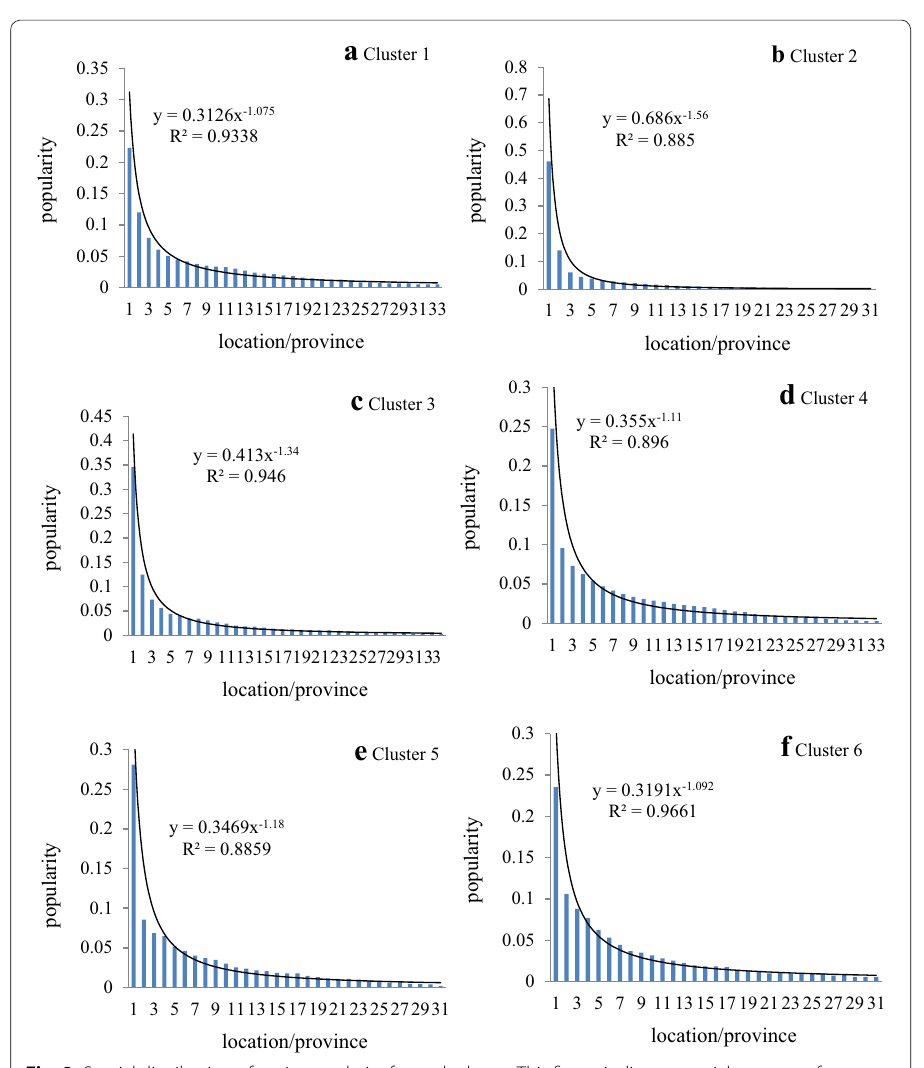
Fig. 8 Spatial distribution of topic popularity for each cluster. This figure indicates spatial patterns of popularity dynamics